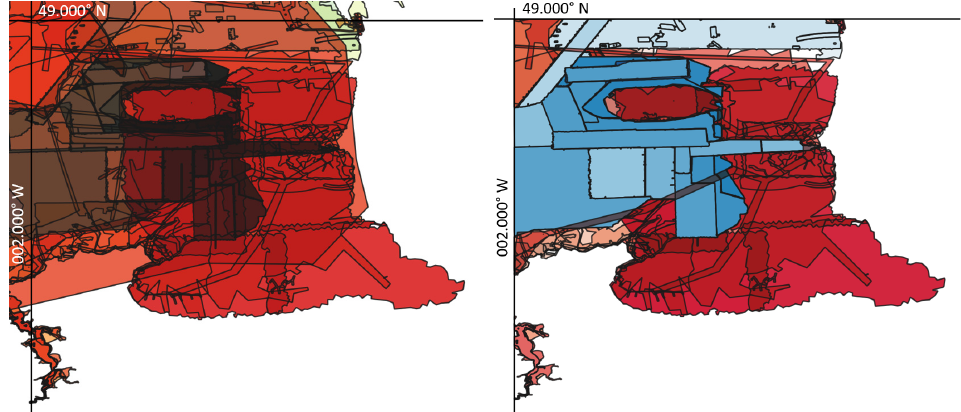
Figure 9. First tile of the Téthys project: on the left , surveys studied for deconfliction; on the right , surveys cut and kept after the deconfliction process (we distinguish easily the remove/restore or supplement decision especially in the blue part on the right side).